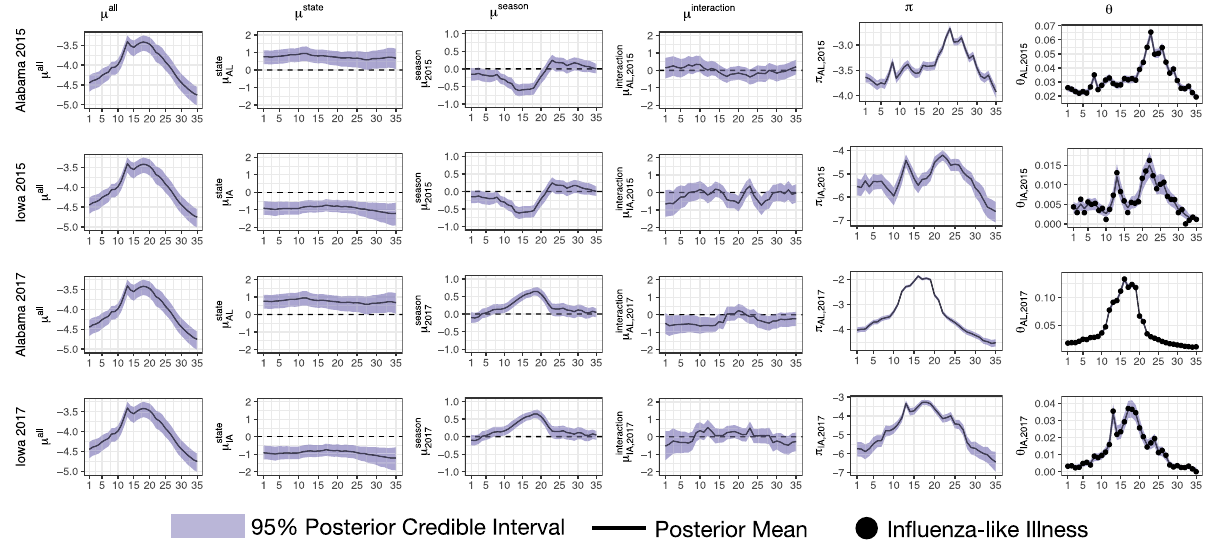
Fig. 9 Posterior summaries of Dante ’ s process model. Posterior summaries for select components, seasons, and states of Dante, fi t to seasons 2010 through 2017. Rows, from top to bottom, correspond to Alabama in 2015, Iowa in 2015, Alabama in 2017, and Iowa in 2017. Columns, from left to right, correspond to μ all , μ state , μ season , μ interaction , π (all from Equation (5)), and θ (Equation (4)). The π column is the sum of the μ all , μ state , μ season , and μ interaction columns, accounting for posterior covariances. The θ column is the inverse logit of the π column and is back on the scale of the data. The μ all component is the most structured component, as it is common for all states and seasons (i.e., the same for all rows). The components μ state and μ season are the next most structured components. They describe the state-speci fi c and season-speci fi c deviations from μ all , respectively, and are common for all seasons within a state ( μ state ) and all states within a season ( μ season ). The component μ interaction is the least structured component of Dante, as it is speci fi c to each season/state (i.e., it is different for each row). Solid lines are posterior means. Ribbons are 95% posterior intervals. In the θ column, points are data, y